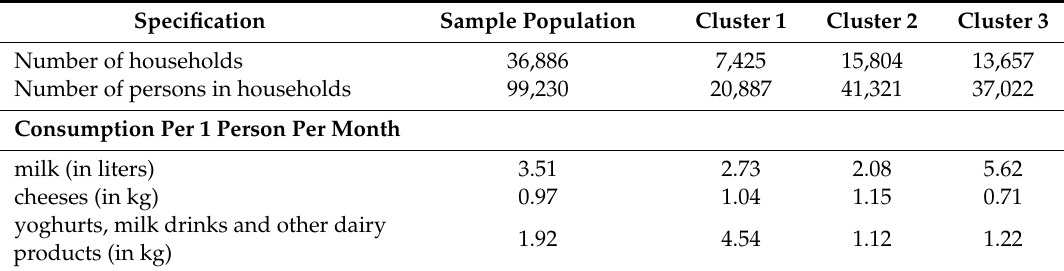
Table 9. Cluster analysis: consumption of main dairy product